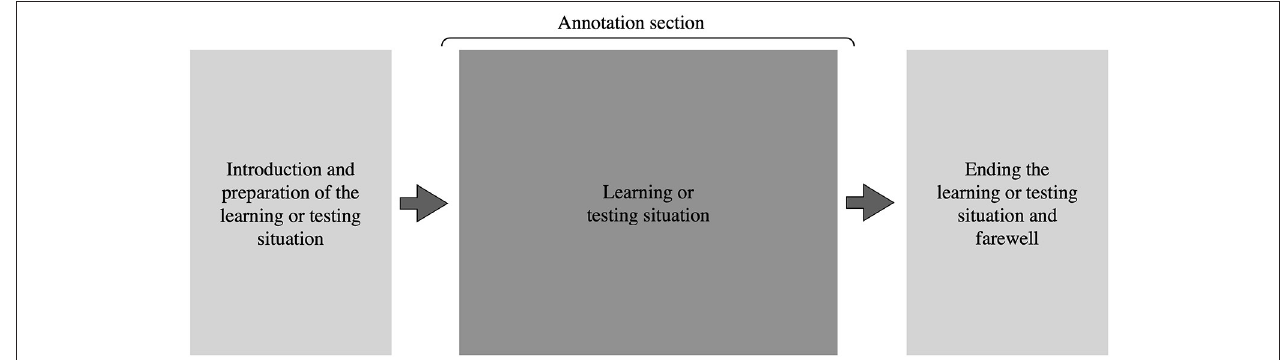
FIGURE 4 | Sequence of the interaction during the sessions and annotated